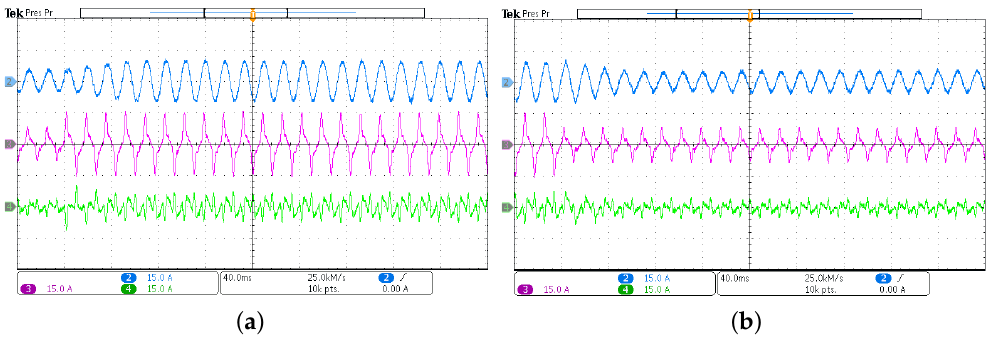
Figure 16. Transient responses, during a change in the power demanded by the NLL, of: (CH2) the grid current i G ; (CH3) the current consumed by the NLL i NLL ; and (CH4) the current injected by the SAPF i AF : ( a ) from low to high load and ( b ) from high to low load (y-axis 15 A/div, x-axis 40 ms/div in all cases).